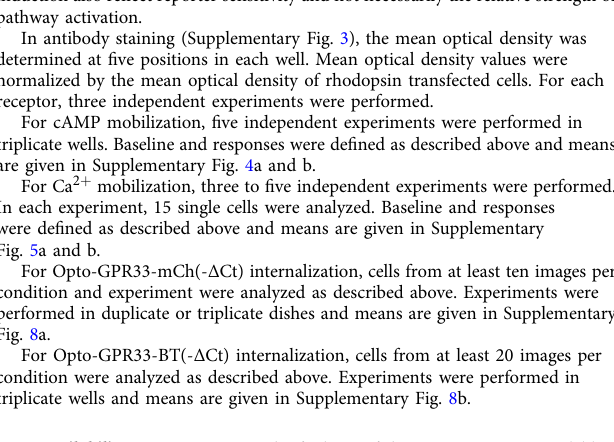
Fig. 8a. For Opto-GPR33-BT(- Δ Ct) internalization, cells from at least 20 images per condition were analyzed as described above. Experiments were performed in triplicate wells and means are given in Supplementary Fig.